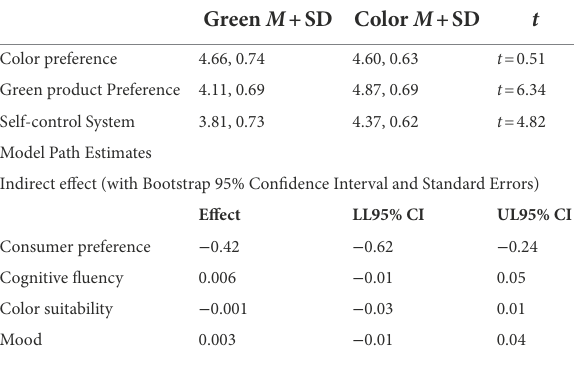
TABLE 2 Study 1: